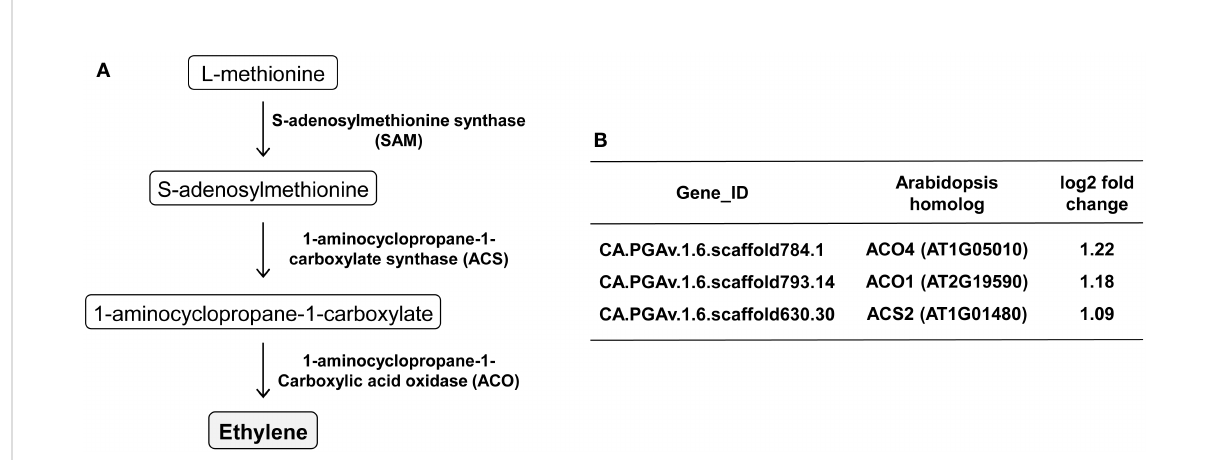
FIGURE 5 Regulation of genes involved in ethylene biosynthesis upon CMV infection in pepper. (A) The ethylene biosynthesis pathway and key enzymes. (B) Ethylene biosynthesis-associated genes upregulated in response to CMV infection. The changes in gene expression were calculated using a log scale of the FPKM data obtained using RNA-seq.